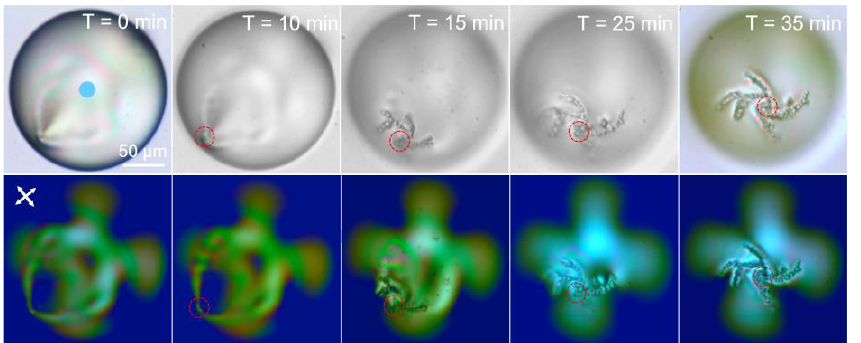
Figure 2. Laser processing of a CLC droplet with an internal structure of twisted radial chains. Laser irradiated (65 µW, 20 s, blue dot) the target CLC droplet and loaded guest water NDs into it. Time-sequenced microscopic images for the self-assembly of injected NDs into the CLC droplet with and without crossed-linear polarizers (white arrows).